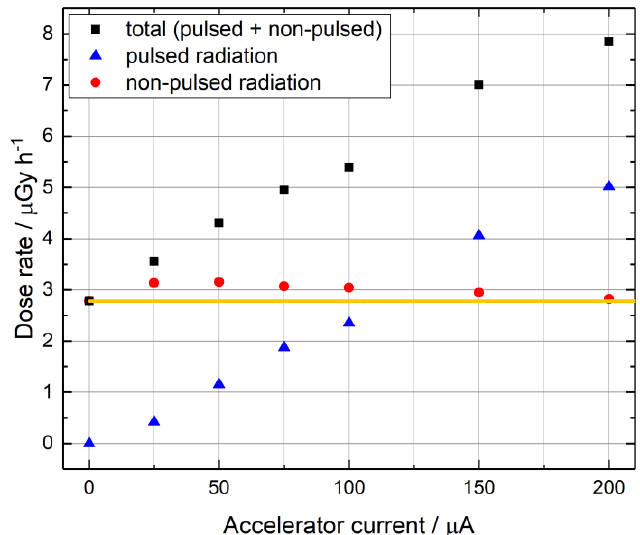
Fig. 6. Total dose rate (assuming the 22 Na source and background), pulsed and non-pulsed radiation dose rates versus accelerator current. Uncertainties are enclosed within markers borders. Orange horizontal line indicates the dose rate measured for the 22 Na source only. For these data, the increase of the accelerator current by 1 μA leads to the increase of the total dose rate and the pulsed radiation dose rate by (25±1) nGy/h and (26.2±0.9) nGy/h